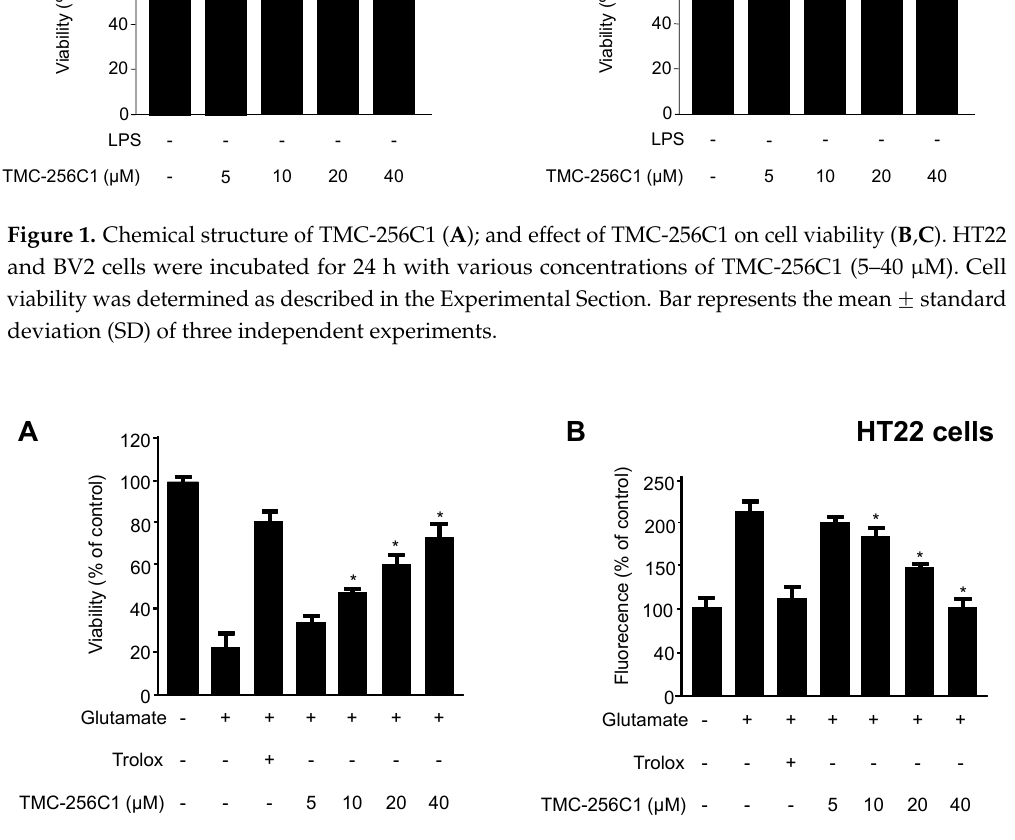
Figure 1. Chemical structure of TMC-256C1 ( A ); and effect of TMC-256C1 on cell viability ( B , C ). HT22 and BV2 cells were incubated for 24 h with various concentrations of TMC-256C1 (5–40 μ M). Cell viability was determined as described in the Experimental Section. Bar represents the mean ± standard deviation (SD) of three independent experiments.